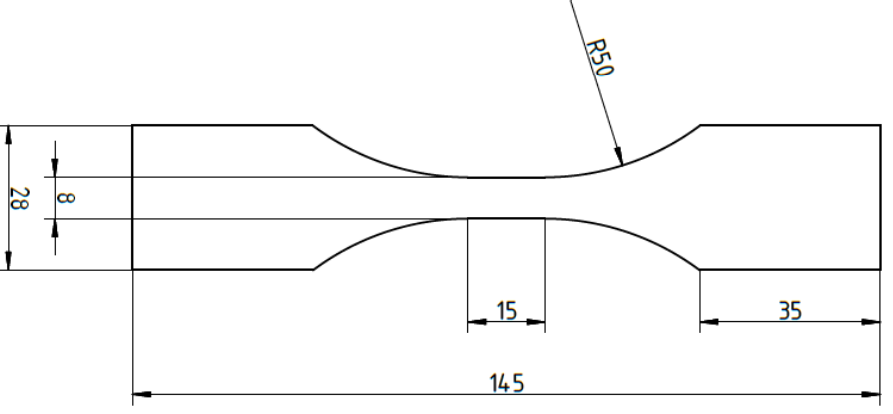
Figure 3. Specimen geometry used for tensile and fatigue testing made of 2 mm thick AISI 304 steel sheet with given dimensions in mm.